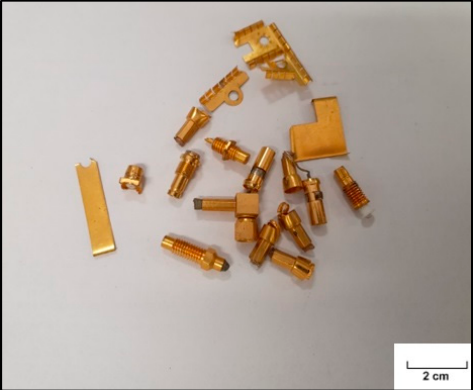
Figure 2. Second sample of connectors.